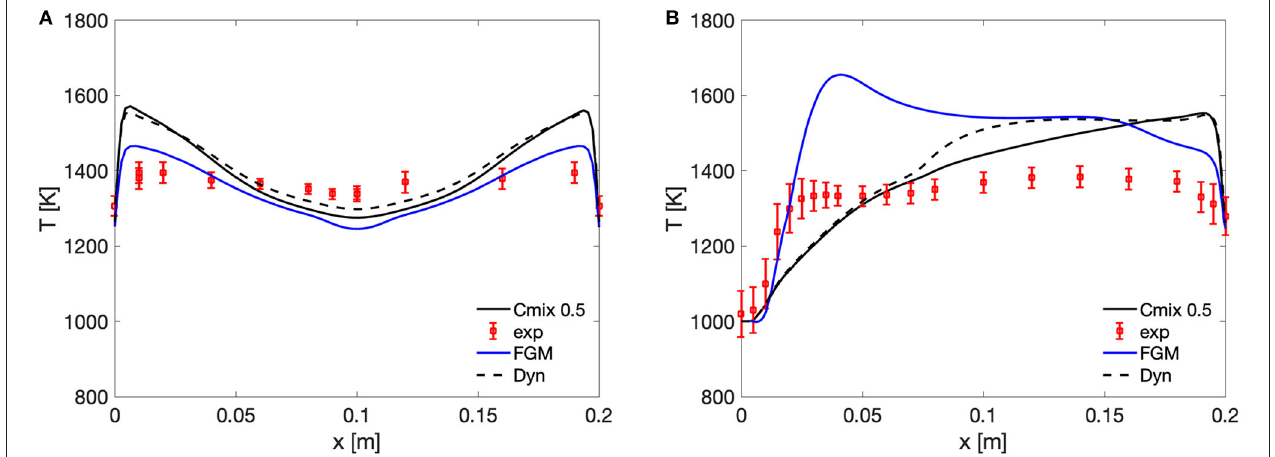
contour for the PaSR dynamic eq